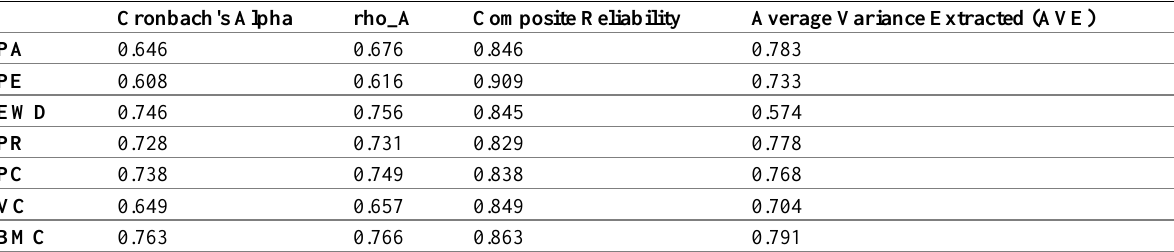
Table 2 : Analysis of Convergent Validity